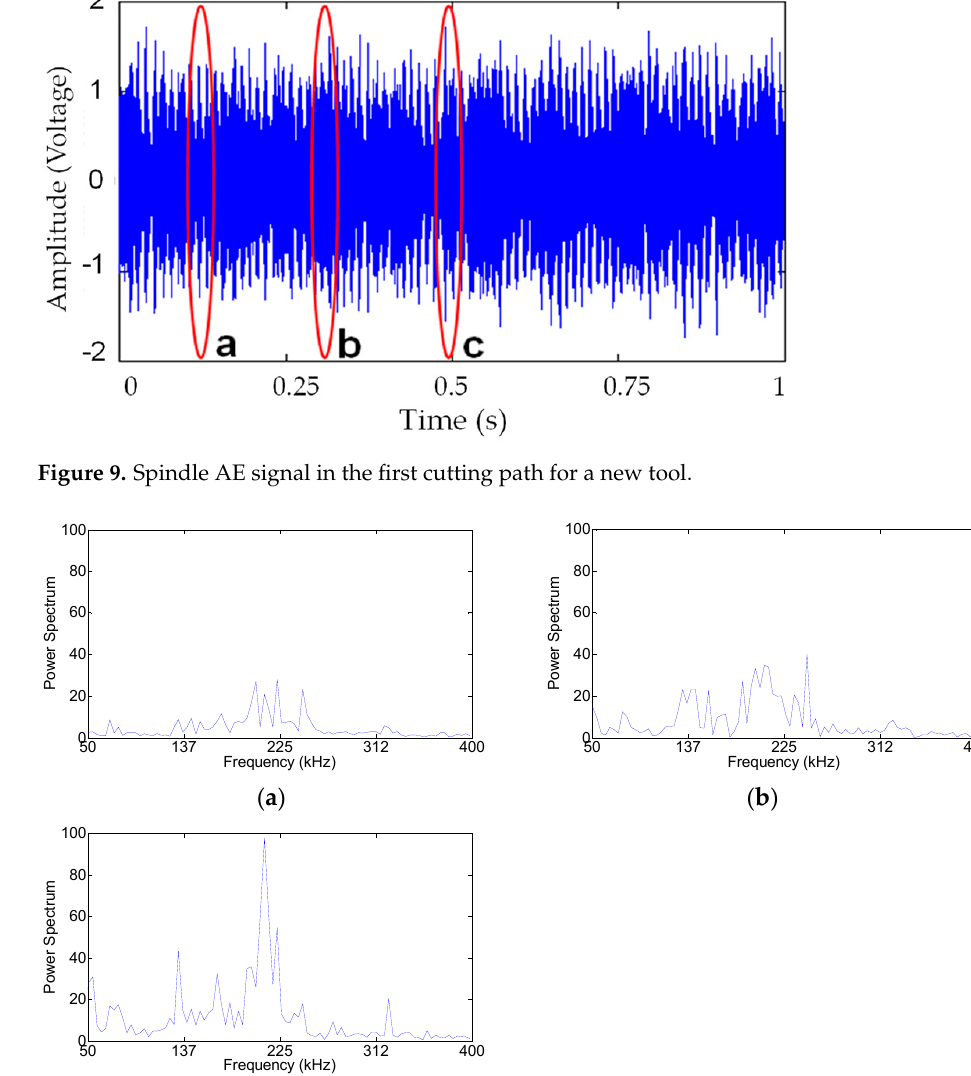
( b ) Figure 8. Scatter index J for tool condition change with ( a ) signals on spindle; ( b ) signals on workpiece. Because of the AE signals generated from the dislocation motion in the material, the signals detected by the AE sensor will closely relate to the chip formation and vary over time, as shown in Figure 9. Figure 8 shows the signals obtained in the first cutting path for a new tool. Therefore, if only a small time period of the signal is chosen for determining the tool condition, it will lose a number of characteristics of signals closely related to tool condition change and create a model that cannot efficiently represent the tool condition. The frequency response of the AE signal corresponding to three time-spans of the signals in Figure 9 are shown in Figure 10. Signal (a) represents the lowest energy period of signals, followed by signal (c). Signal (b) represents the highest energy for the collected signals. By comparing the frequency domain signal for three spans of signals in Figure 10, the frequency locations of the top energy features do not change considerably for the three cases; however, the feature energy level changes over the three cases. This result proves